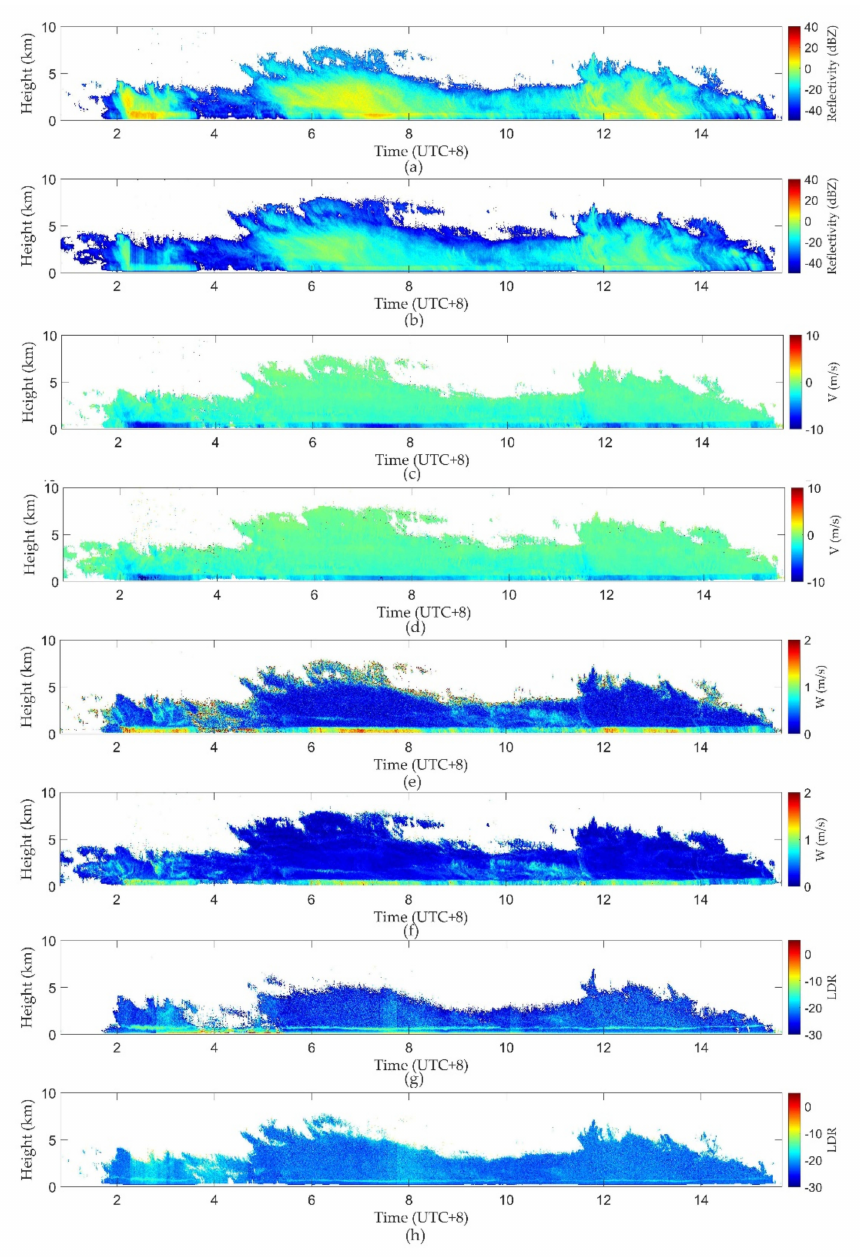
Figure 4. The ( a , b ) Z e , ( c , d ) V , ( e , f ) W and ( g , h ) LDR measured by the DDCR on 11 August 2019 by the ( a , c , e , g ) Ka-band radar and ( b , d , f , h ) W-band radar,